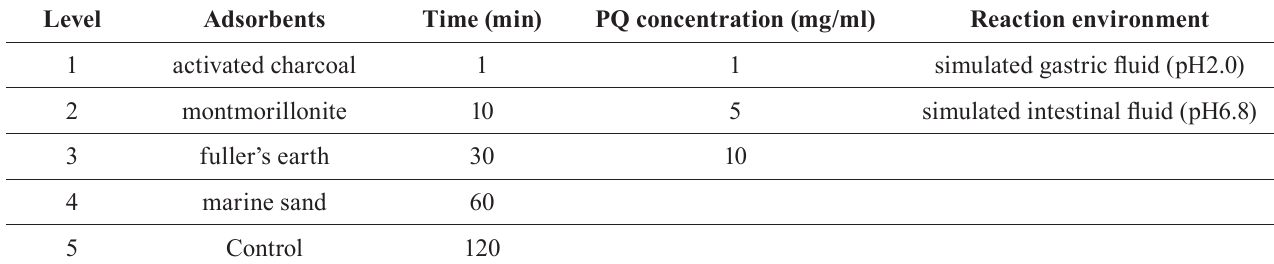
TABLE I - O rthogonal design of in vitro test